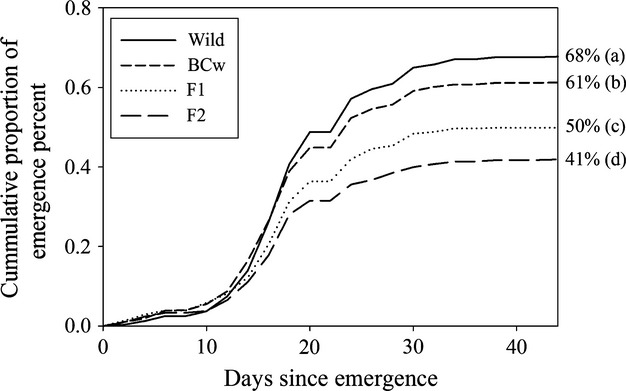
Emergence curves and percent spring emergence for each of the four sunflower crop–wild hybrid cross types grown during our experiment in Jefferson County, Kansas: W, BCw, F1, and F2. Curves were generated using data from all emerged individuals (n = 2670), while percent spring emergence was generated using data from all original fall planted focal seeds (n = 4805). Spring emergence percentages for each cross type, along with mean separation results for those percentages, are located to the right-hand side of each curve. Standard errors ranged from 0.016 to 0.019. Cross types marked with different letters are significantly different at 0.05 level—Tukey–Kramer adjustment for multiple comparisons. Late emergence events (past day 44) for the W, BCw, and F1 cross types and standard error bars for the emergence curves have been removed for clarity—standard errors ranged from 0 to 0.0203. The first day of emergence for the experiment was recorded on March 22, 2010 (day 1). Log rank test for failure-time analysis between cross types: P = 0.1188. BCw–F1 backcrossed onto a wild parent.